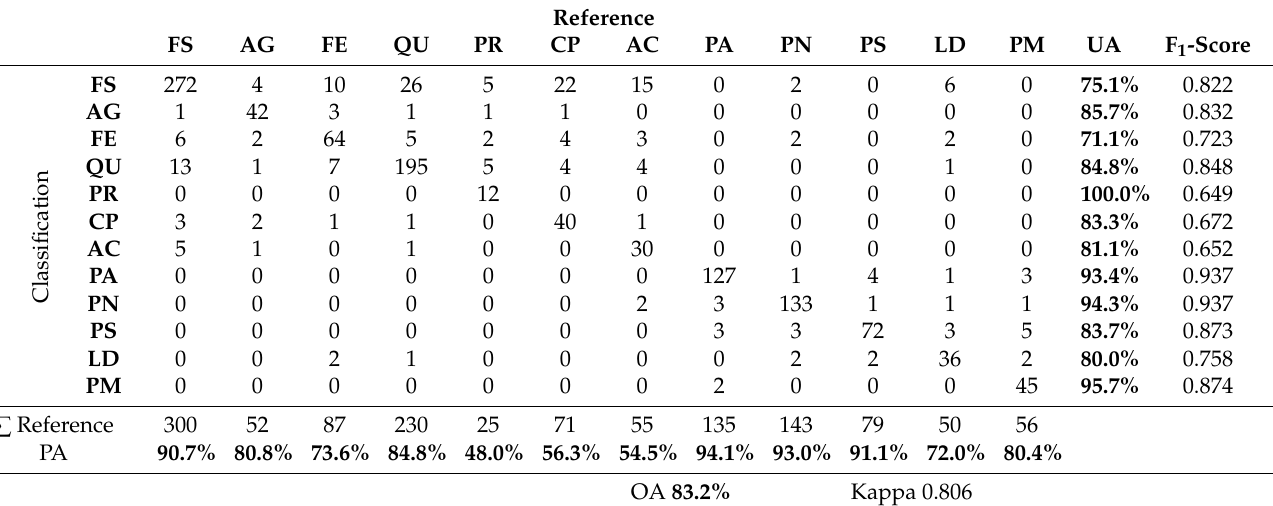
Table 7. Confusion matrix based on the out-of-bag-result of Test case 2, using only Sentinel-2 data. UA: user’s accuracy, PA: producer’s accuracy, OA: overall accuracy; for the abbreviations of tree species names see Figure